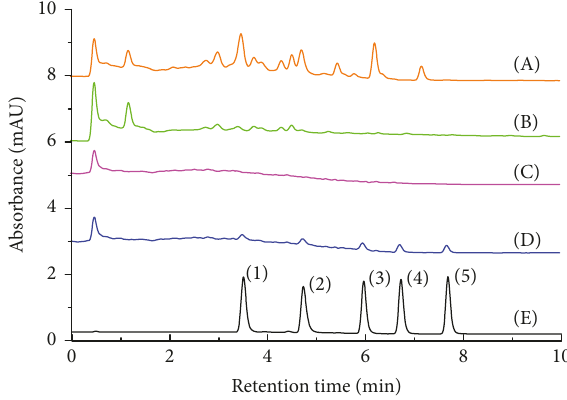
Figure 8: UHPLC-FLD chromatograms of samples and the stan- dard solution: (A) blank urine sample without SPE cleanup; (B) blank urine sample after C18 SPE cleanup; (C) blank urine sam- ple after BTO-SPE SPE cleanup; (D) urine sample spiked with 0.02 𝜇 g mL −1 standard solution of five anthraquinones; (E) standard solution of five anthraquinones (0.5 𝜇 g mL −1 ) (peaks: (1) aloe- emodin; (2) rhein; (3) emodin; (4) chrysophanol; (5)